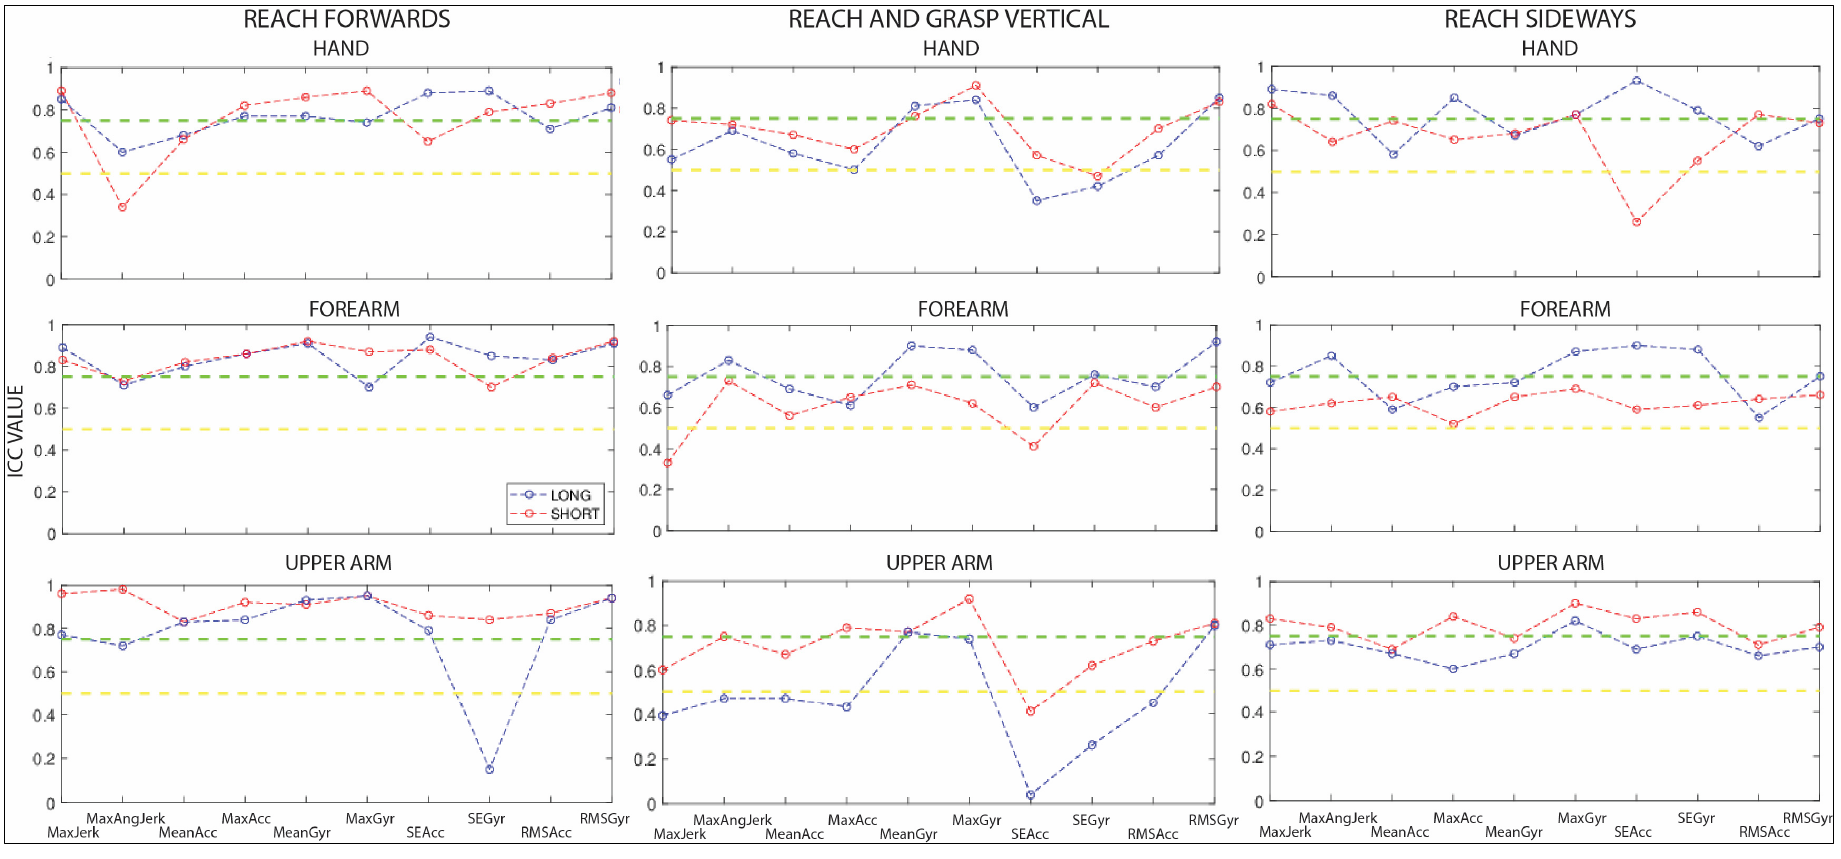
Figure 3. Between-session ICC values of the different sensor parameters for reach forwards, reach-and-grasp vertical, and reach sideways for the DCP group. The green and yellow dotted lines depict the limit of good and moderate correlations, respectively. Blue and red lines are for illustrative purposes.